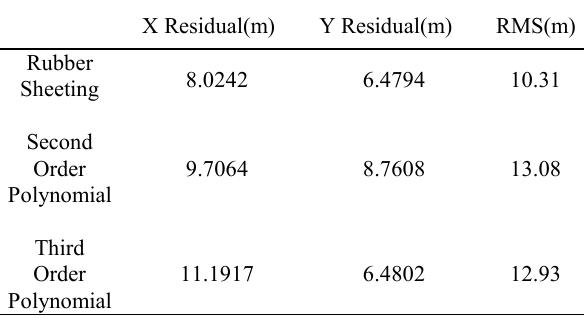
Table 2. Accuracy comparison of check